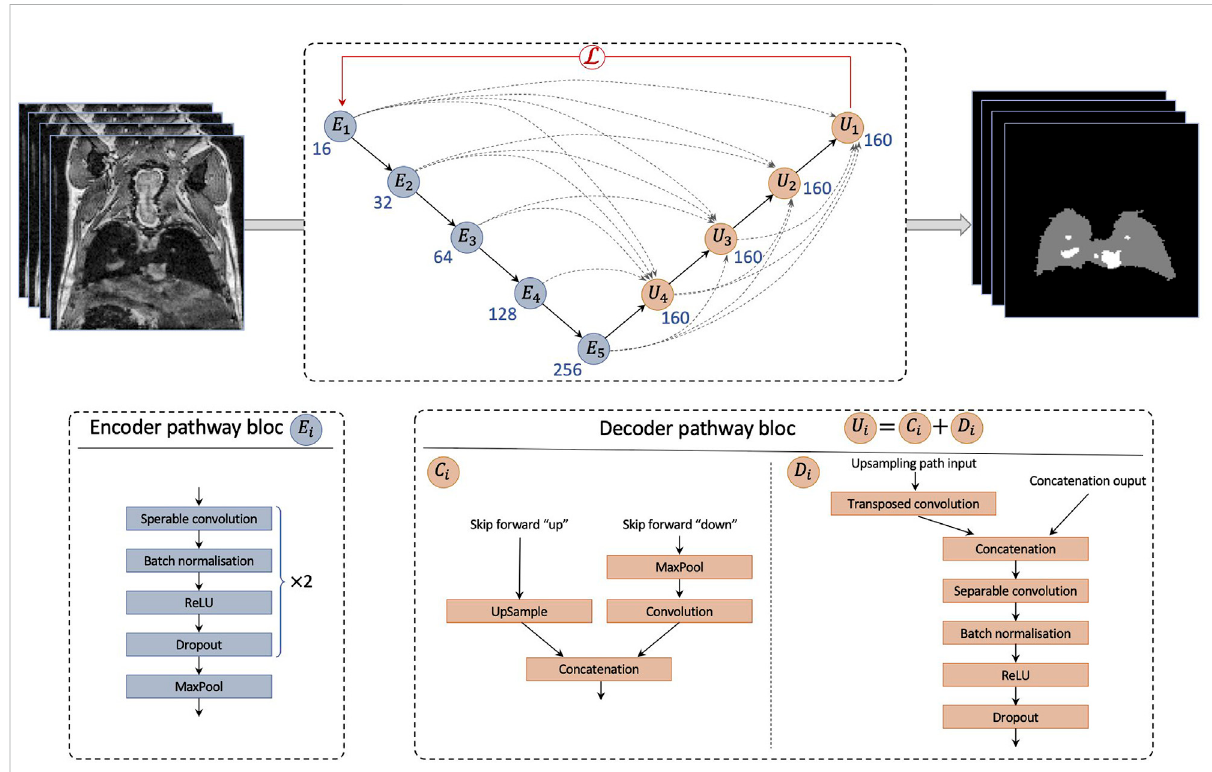
FIGURE 1 Architecture of DeepMeta network for lung and metastases segmentation. The network is composed of an encoder path and a decoder path. The encoder is composed of E i blocks. The decoder is composed by U i blocks composed by a concatenation block C i and a decoder block D i . C i blocks up sample or down sample feature maps into the same size as the upsampling path input and then pass it to D i